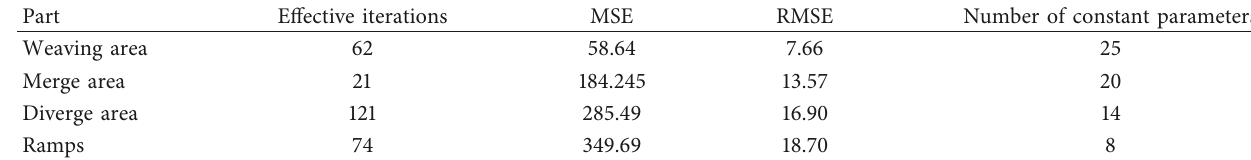
Table 5: A brief outlook of applying the optimization process on all parts of interchanges.